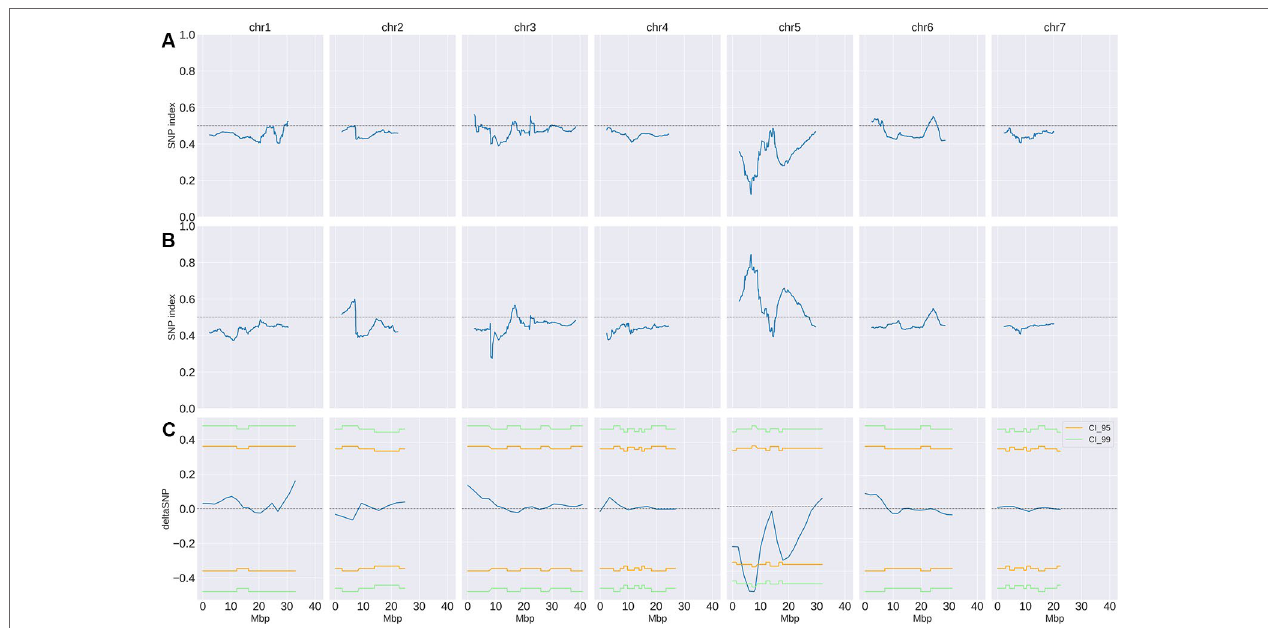
FIgURe 3 | SNP-index and Δ(SNP-index) distribution (blue line). SNP-index for R-bulk (A) and S-bulk (B) was calculated using sliding windows of 4.7 Mbp in length with a step measuring 10 kb. The corresponding Δ(SNP-index) (C) was calculated as the difference SNP-index R-bulk – SNP-index S-bulk. Regions of statistical significance are detected as those that surpass the threshold of 0.95 (orange line) or 0.99 (green line) confidence intervals.